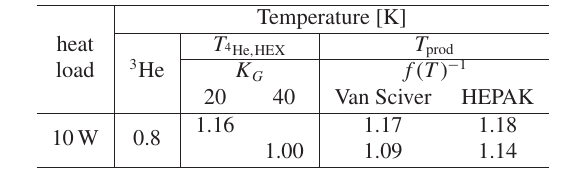
Table 2. Important temperatures of the UCN source cryostat. The conversion factor a (see Eq. (6) is assumed to be